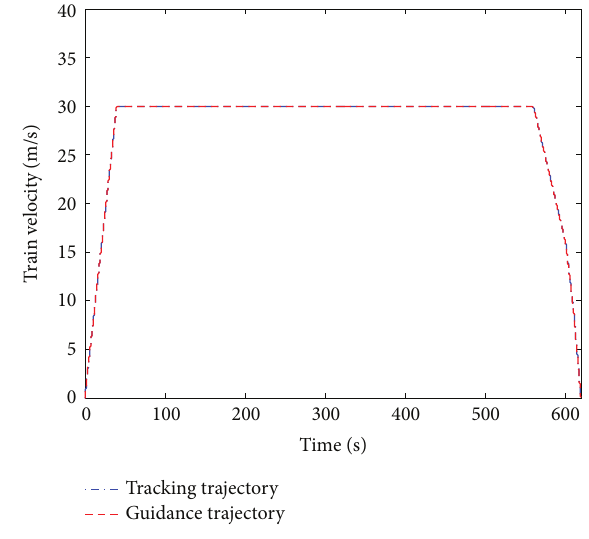
Figure 2: Train velocity tracking curve (this paper).